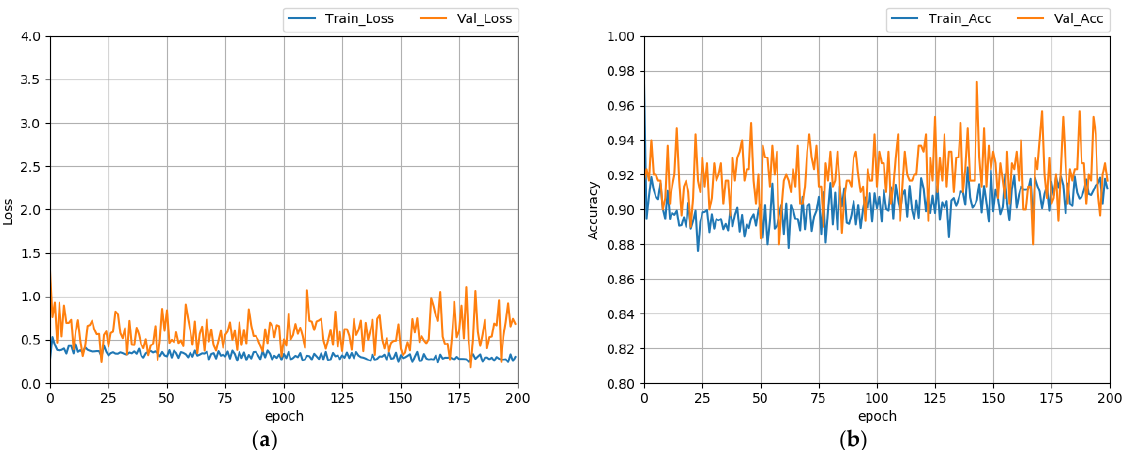
Figure A5. Stage 2 training result of the proposed learning method with the triplet loss. ( a ) triplet loss; ( b ) accuracy. Second, the proposed model was trained with the ArcFace in stage 1. Figure A6 illus- trates the training results.